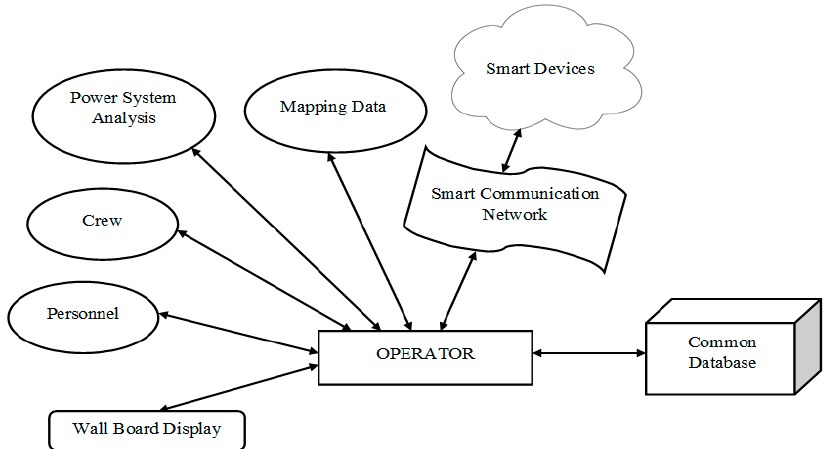
Figure 2. Structure of SCADA for power